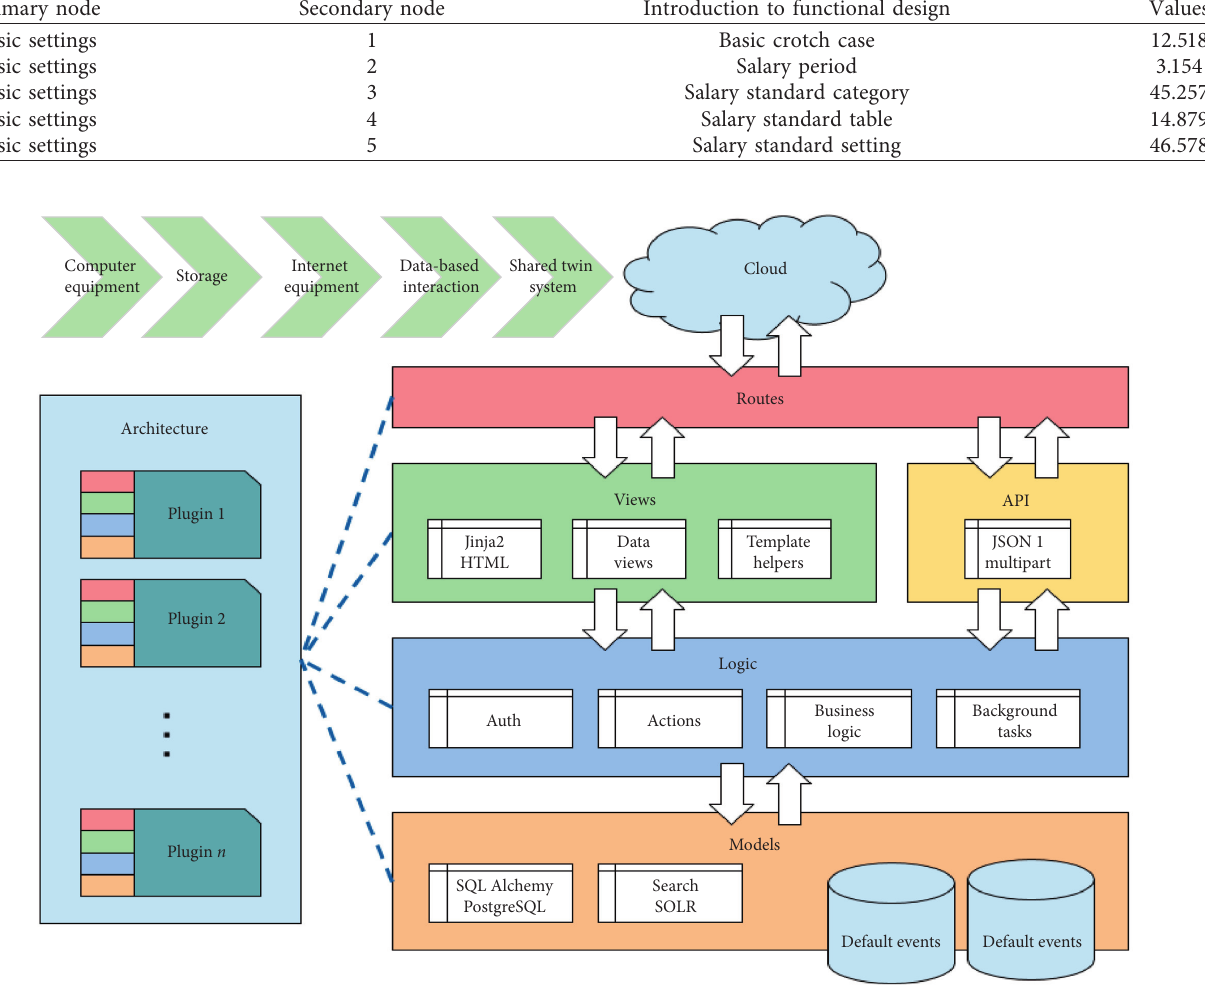
Figure 4: Optimized design